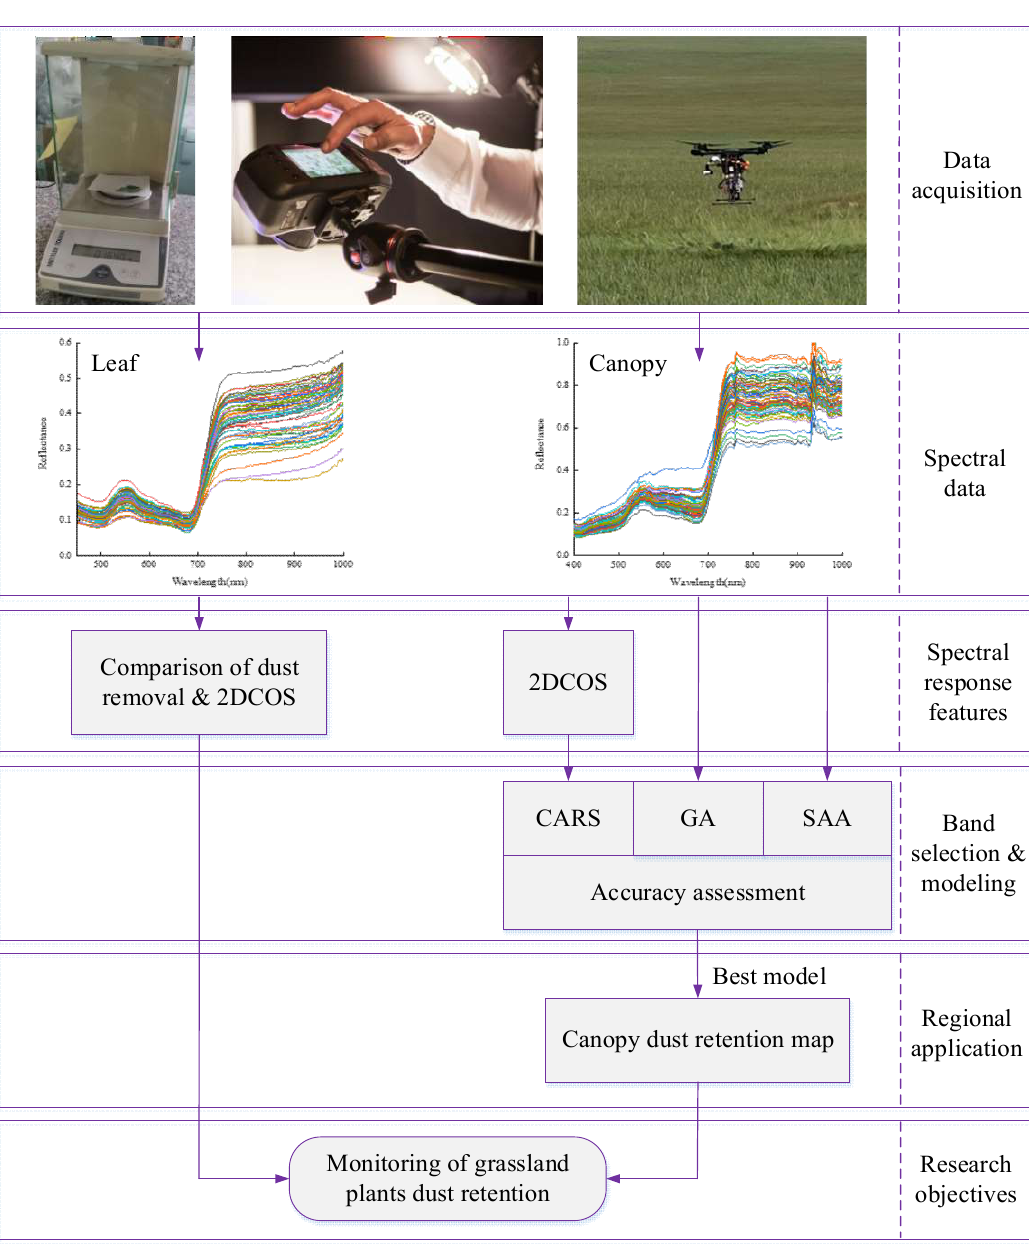
Figure 1. Workflow of spectral response and estimation study of grassland plant dust retention.